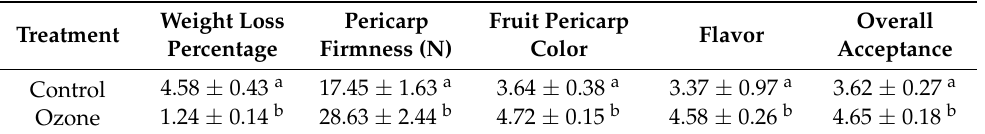
Table 1. Assessment of the quality and sensory evaluation of mangosteen during coloration from light greenish yellow with 5–50% scattered pinkish spots to uniformly dark purple. Weight Loss Pericarp Fruit Pericarp Overall Treatment Flavor Percentage Firmness (N) Color Acceptance 4.58 ± 0.43 a 17.45 ± 1.63 a 3.64 ± 0.38 a 3.37 ± 0.97 a 3.62 ± 0.27 a Control 1.24 ± 0.14 b 28.63 ± 2.44 b 4.72 ± 0.15 b 4.58 ± 0.26 b 4.65 ± 0.18 Ozone